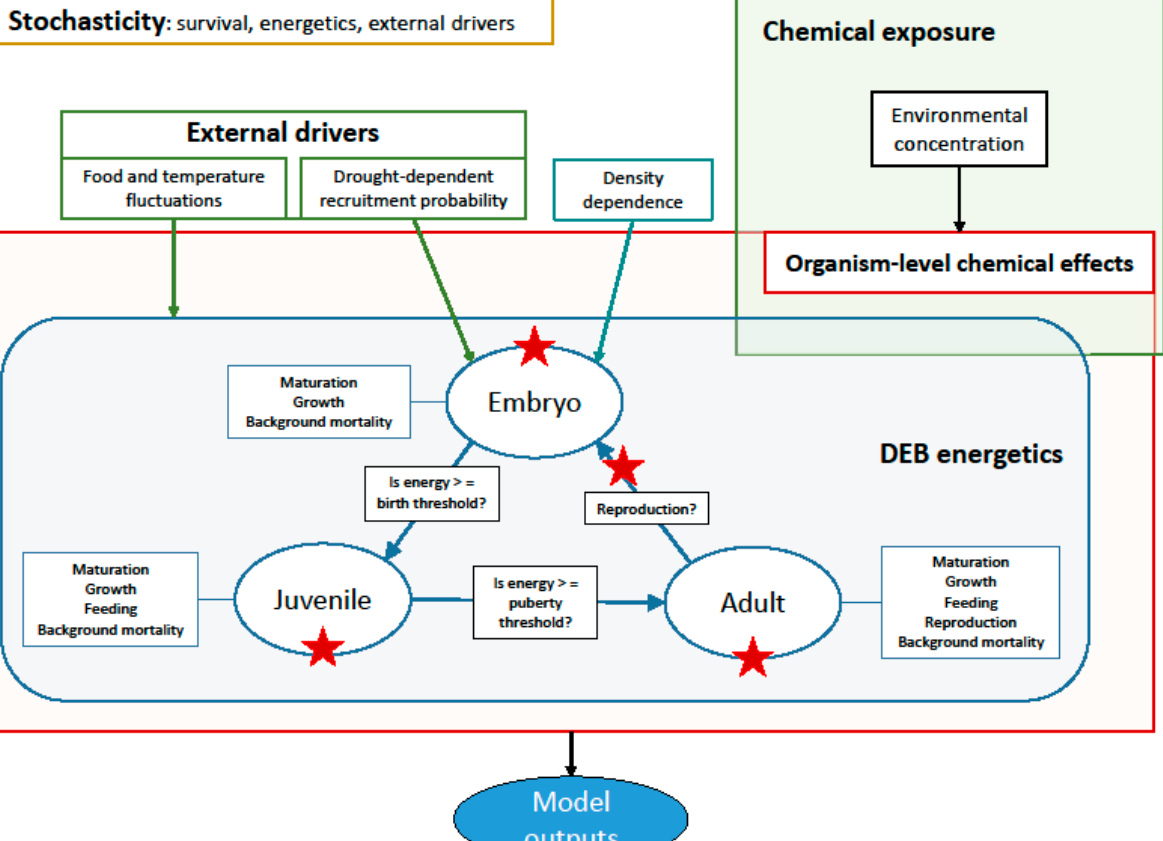
Figure 1. Conceptual model diagram. The individual-level processes follow DEB rules and are represented in the blue box. External drivers such as drought-dependent mortality, food fluctuations, and chemical exposure are highlighted in green. The yellow box shows where stochasticity is introduced in the model. Density dependence affects embryo survival. The chemical affects organism-level processes including juvenile and adult survival, hatching success, and egg production (shown by the red